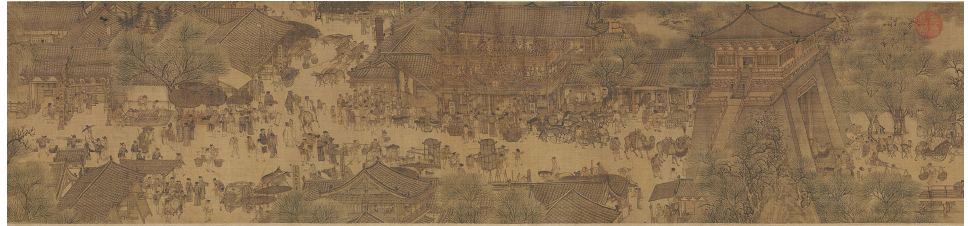
Figure 16. Part of the Qingming Shanghe